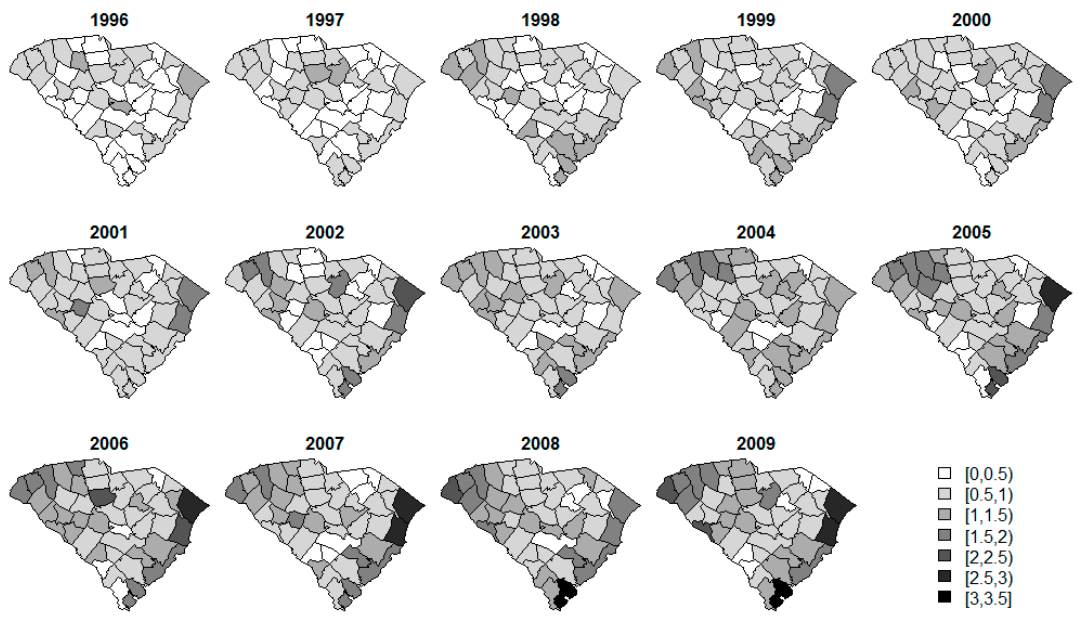
Figure 3. SIR of melanoma cancer of the skin.